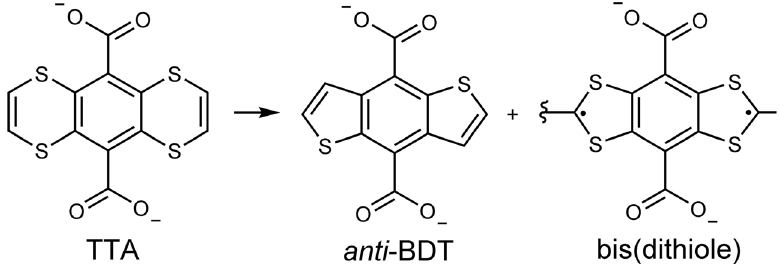
Fig.1|TransformationoftheTTAlinkerintheEuTTAcrystal. ThechemicalstructuresoftheTTAlinkermolecule(left),the anti -BDT(middle),andbis(dithiole)(right) species; the latter two are generated by heating the EuTTA